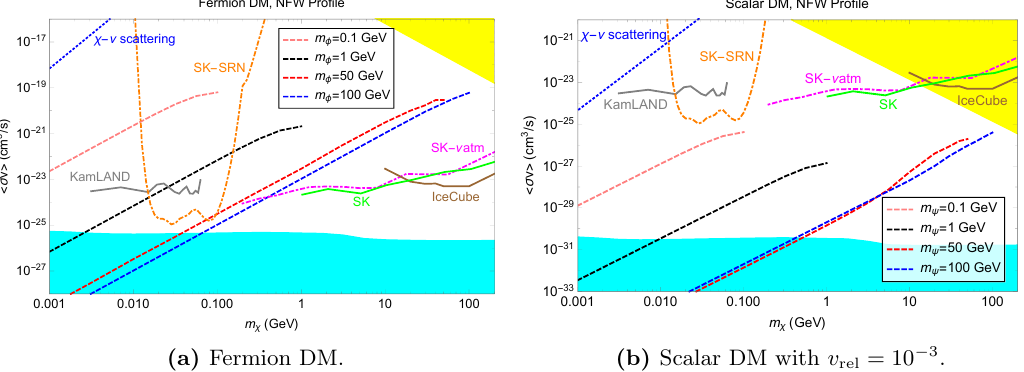
Figure 9. The 90% CL bounds from various neutrino telescope observations compared with the collider bounds. The gray line, labelled KamLAND, is the (rescaled) o(cid:14)cial KamLAND bound [69]. The green line, labelled SK, is the o(cid:14)cial SK bound [68]. The brown line, labelled IceCube, is the o(cid:14)cial IceCube bound [67]. The orange, dot-dashed line, labelled SK-SRN, is the bound obtained from recasting the SK SRN searches discussed in section 4.1. The magenta, dot-dashed line, la- belled SK- (cid:23) atm, is the bound obtained from recasting the SK atmospheric neutrino measurements discussed in section 4.2. The shaded yellow region is excluded by perturbativity constraint on the DM-neutrino coupling, y , and the constraint m (cid:31) m (cid:30) ( ) . The shaded cyan region is the region (cid:20) that gives (cid:10) (cid:31) h 2 > 0 : 1186 simulated using Micromegas 5.0 [80]. The blue dotted lines are the cos- mological bounds from the DM-neutrino scattering discussed in section 2.2. For the collider bounds (dashed lines), we only show strongest bound between the LHC and the invisible Z decay